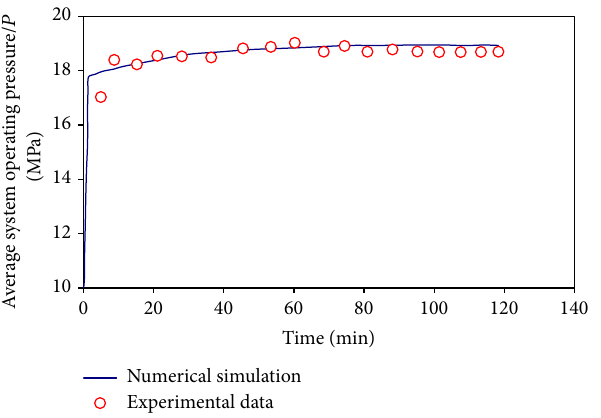
Figure 6: Comparison of the average system operating pressure predicted by the model and the laboratory measurements.